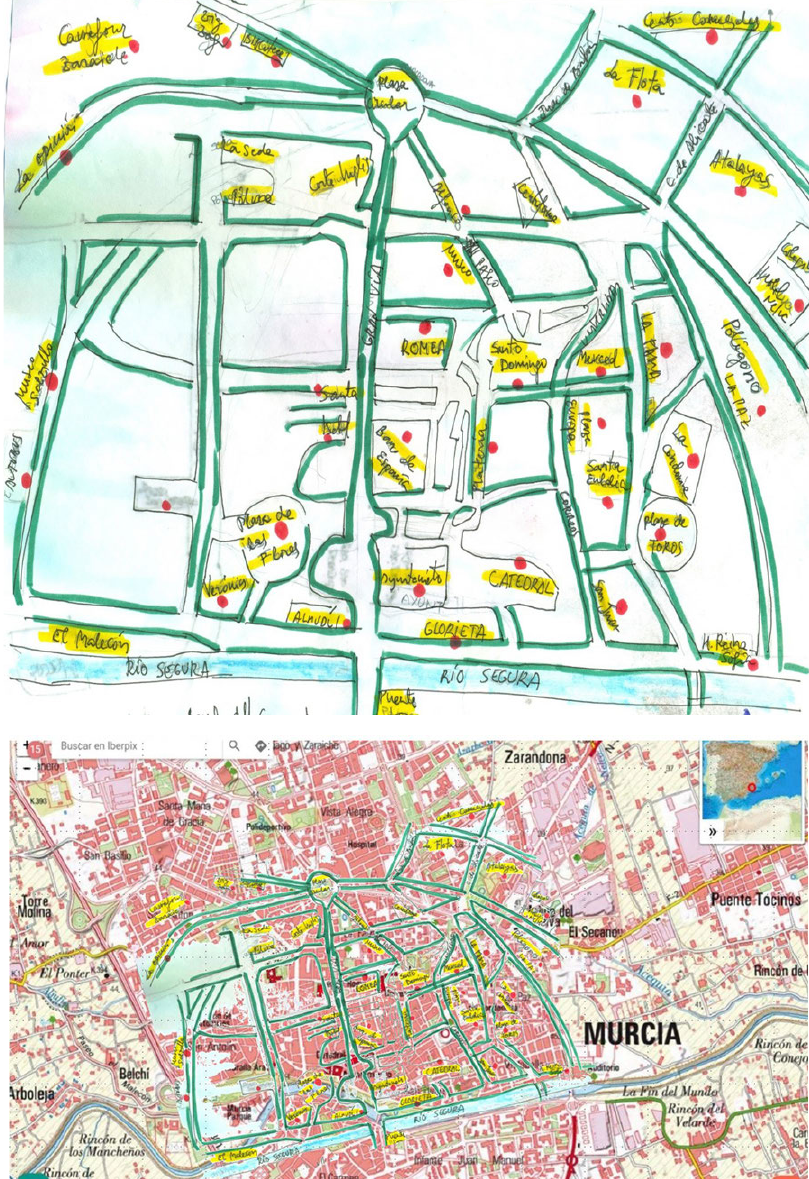
Fig. 2. A sketch of Murcia students’ perception and the same perception on a real map of